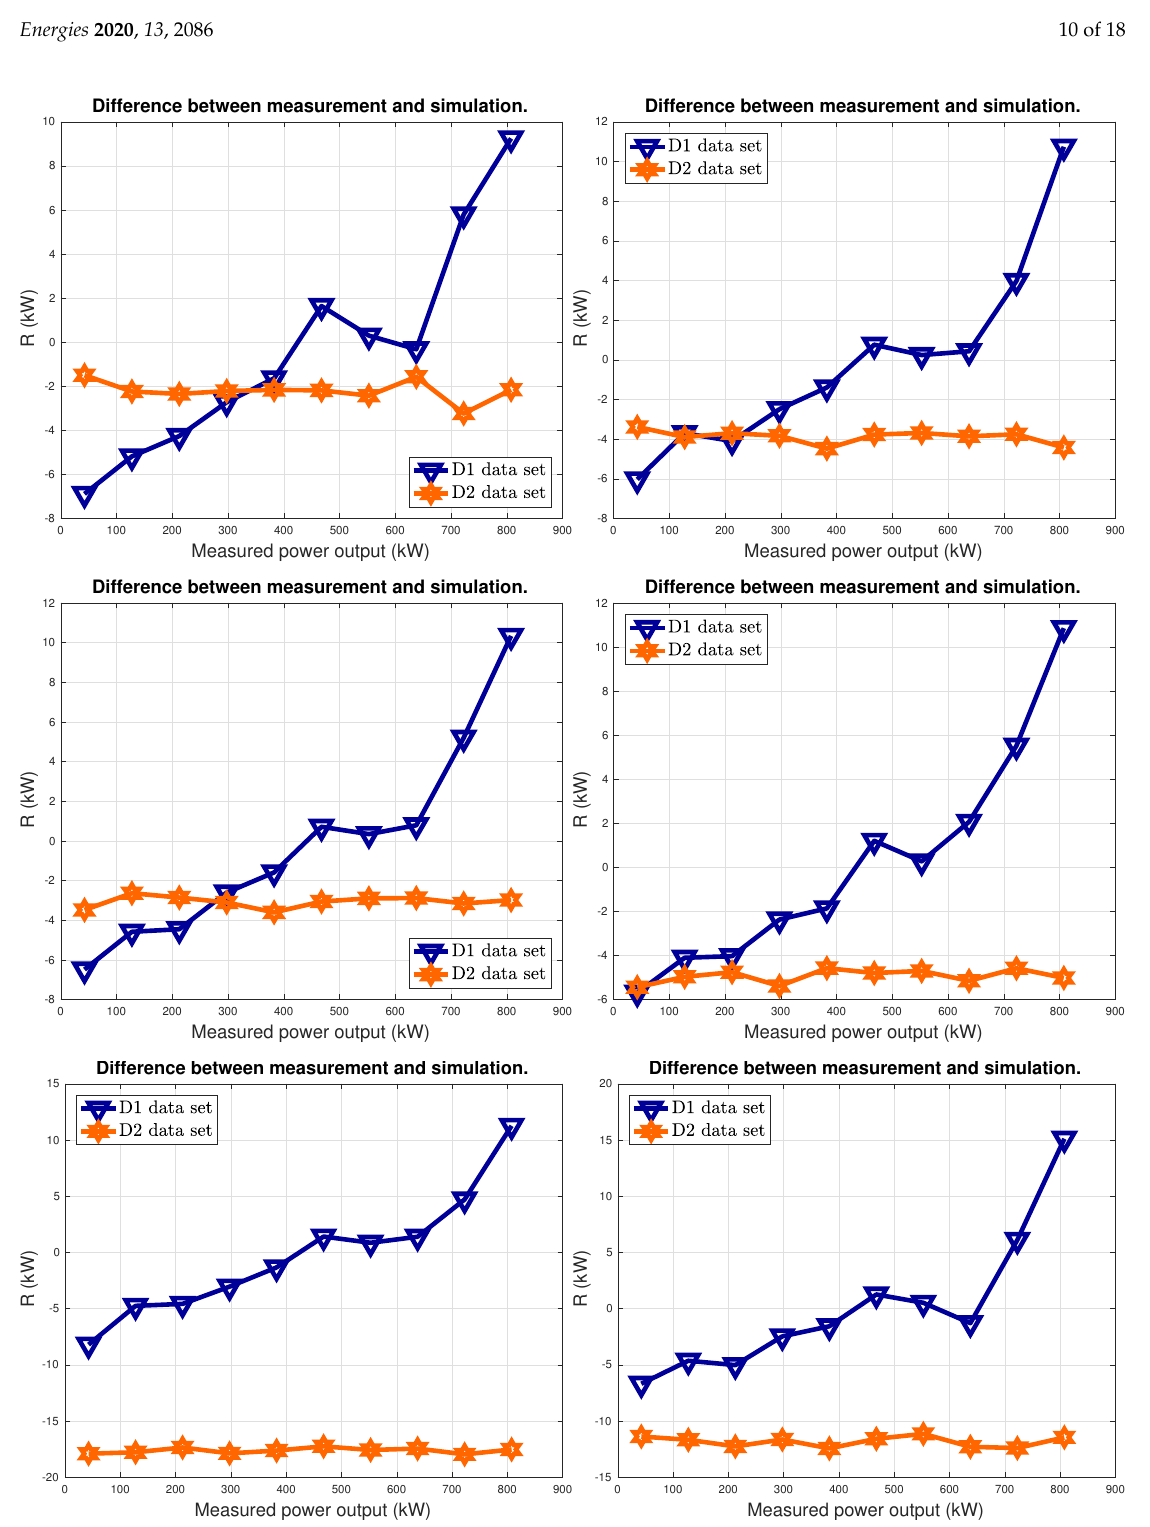
Difference between measurement and simulation.